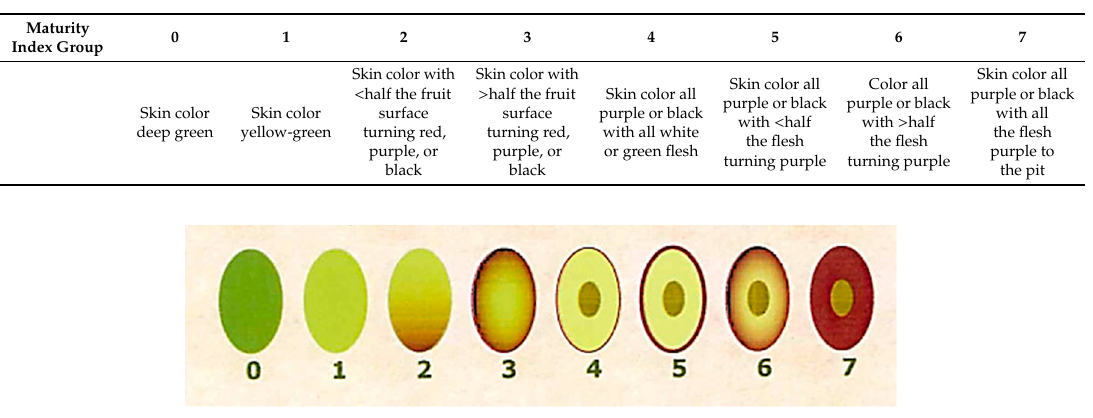
Figure 1. Ripening index according to the different color of the fruit.